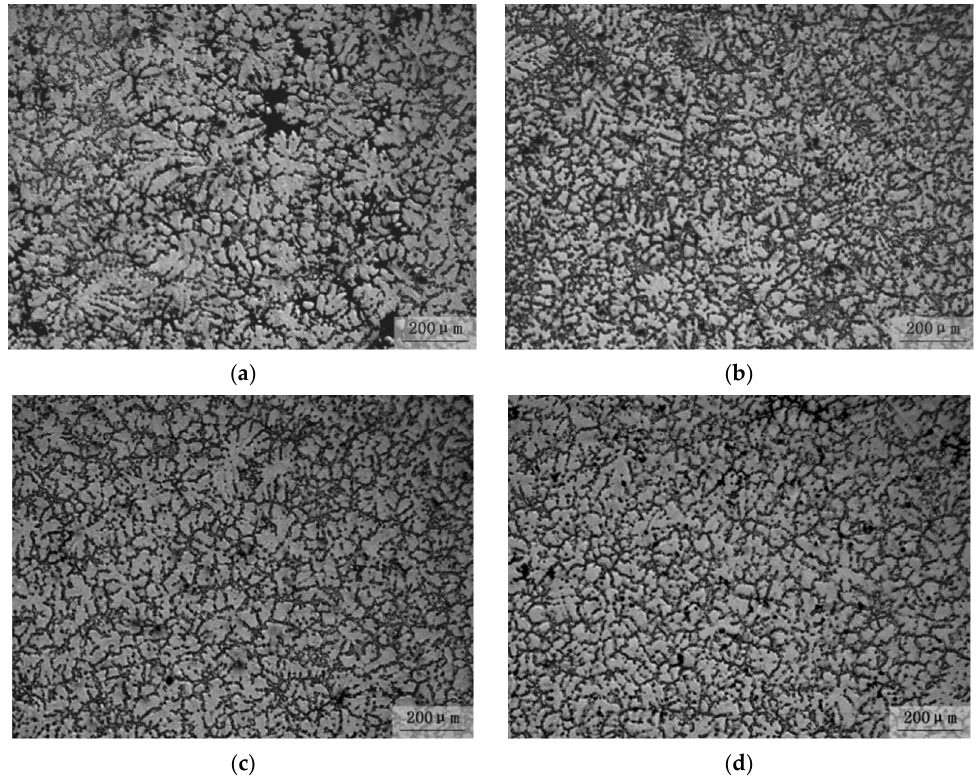
Figure 11. Variation of microstructures in AZ91 alloy by ultrasonic treating time. ( a ) 0 s; ( b ) 30 s; ( c ) 90 s; ( d ) 150 s.